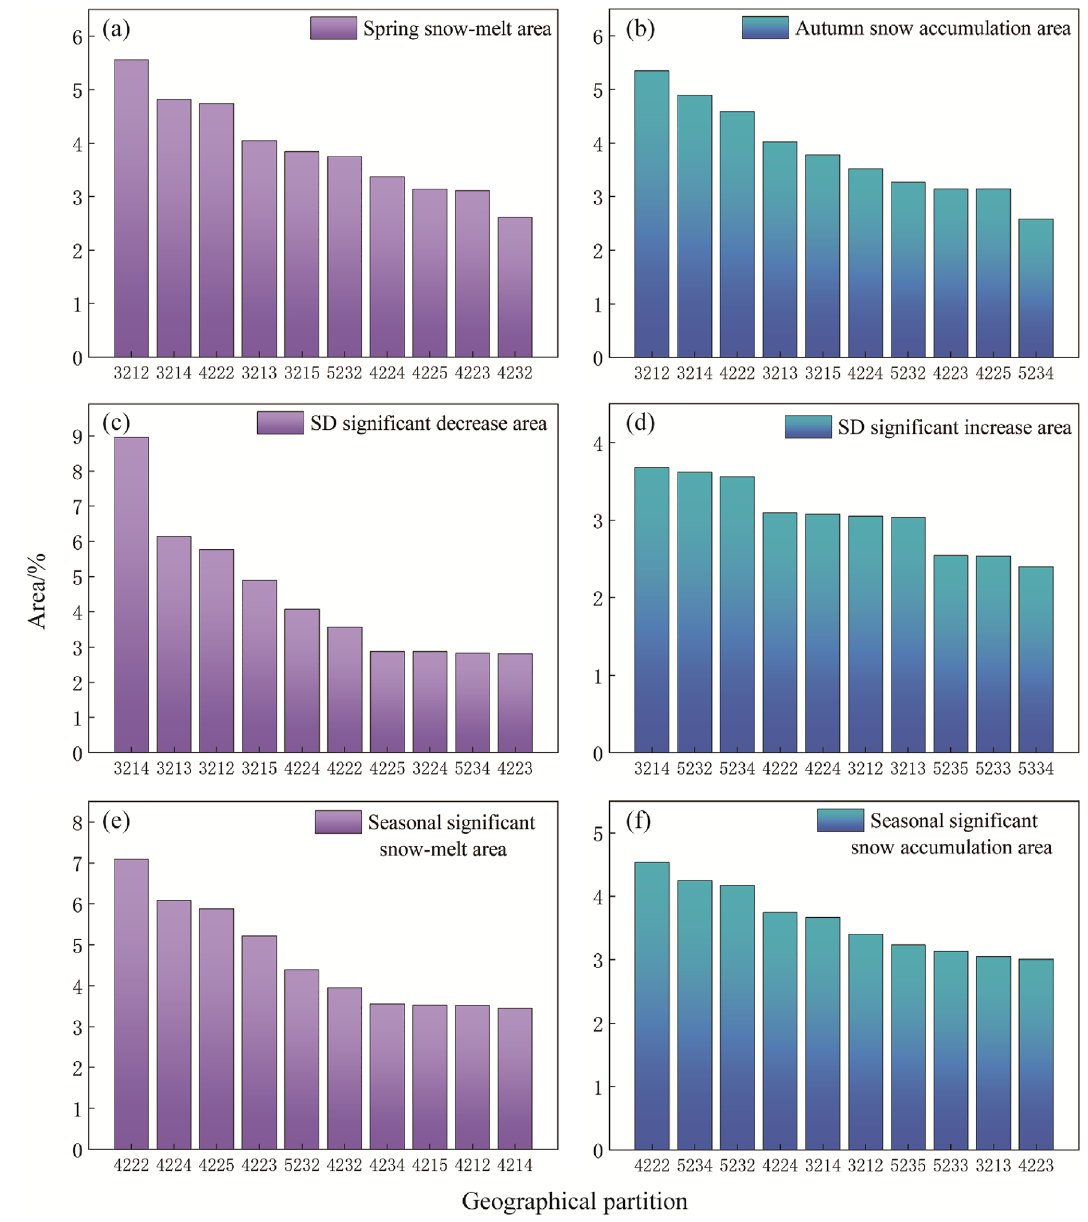
Figure 10. Percentage distribution of geographical partitions area and snow evolution